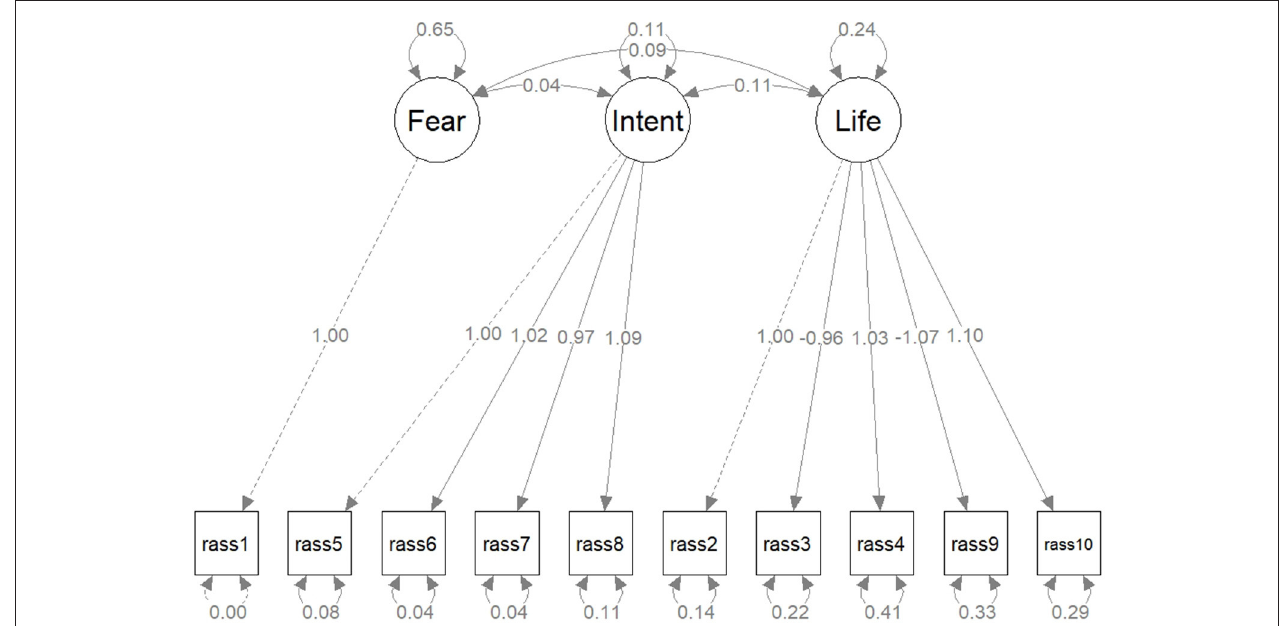
FIGURE 2 | The path diagram for the confirmatory factor analysis for the first 10 items of the RASS scale, based on the three factors originally identified: fear, intention, and life. Latent variables are drawn in circles and manifest variables are drawn in squares. The edge labels indicate the parameter estimates.